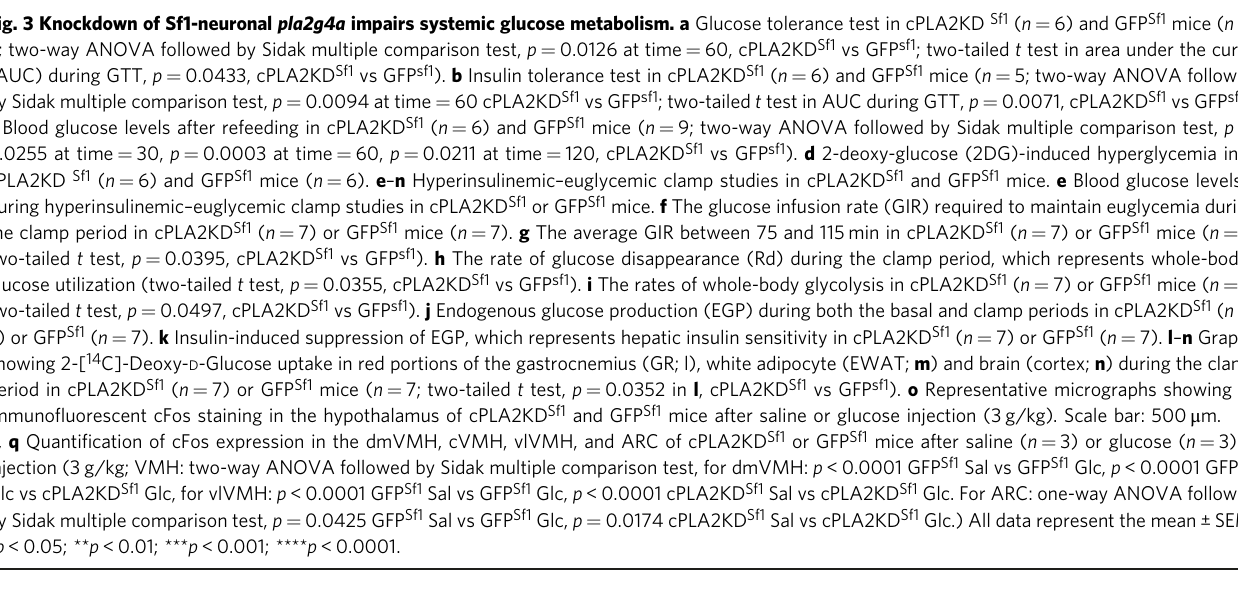
Fig. 3 Knockdown of Sf1-neuronal pla2g4a impairs systemic glucose metabolism. a Glucose tolerance test in cPLA2KD Sf1 ( n = 6) and GFP Sf1 mice ( n = 6; two-way ANOVA followed by Sidak multiple comparison test, p = 0.0126 at time = 60, cPLA2KD Sf1 vs GFP sf1 ; two-tailed t test in area under the curve (AUC) during GTT, p = 0.0433, cPLA2KD Sf1 vs GFP sf1 ). b Insulin tolerance test in cPLA2KD Sf1 ( n = 6) and GFP Sf1 mice ( n = 5; two-way ANOVA followed by Sidak multiple comparison test, p = 0.0094 at time = 60 cPLA2KD Sf1 vs GFP sf1 ; two-tailed t test in AUC during GTT, p = 0.0071, cPLA2KD Sf1 vs GFP sf1 ). c Blood glucose levels after refeeding in cPLA2KD Sf1 ( n = 6) and GFP Sf1 mice ( n = 9; two-way ANOVA followed by Sidak multiple comparison test, p = 0.0255 at time = 30, p = 0.0003 at time = 60, p = 0.0211 at time = 120, cPLA2KD Sf1 vs GFP sf1 ). d 2-deoxy-glucose (2DG)-induced hyperglycemia in cPLA2KD Sf1 ( n = 6) and GFP Sf1 mice ( n = 6). e – n Hyperinsulinemic – euglycemic clamp studies in cPLA2KD Sf1 and GFP Sf1 mice. e Blood glucose levels during hyperinsulinemic – euglycemic clamp studies in cPLA2KD Sf1 or GFP Sf1 mice. f The glucose infusion rate (GIR) required to maintain euglycemia during the clamp period in cPLA2KD Sf1 ( n = 7) or GFP Sf1 mice ( n = 7). g The average GIR between 75 and 115 min in cPLA2KD Sf1 ( n = 7) or GFP Sf1 mice ( n = 7; two-tailed t test, p = 0.0395, cPLA2KD Sf1 vs GFP sf1 ). h The rate of glucose disappearance (Rd) during the clamp period, which represents whole-body glucose utilization (two-tailed t test, p = 0.0355, cPLA2KD Sf1 vs GFP sf1 ). i The rates of whole-body glycolysis in cPLA2KD Sf1 ( n = 7) or GFP Sf1 mice ( n = 7; two-tailed t test, p = 0.0497, cPLA2KD Sf1 vs GFP sf1 ). j Endogenous glucose production (EGP) during both the basal and clamp periods in cPLA2KD Sf1 ( n = 7) or GFP Sf1 ( n = 7). k Insulin-induced suppression of EGP, which represents hepatic insulin sensitivity in cPLA2KD Sf1 ( n = 7) or GFP Sf1 ( n = 7). l – n Graphs showing 2-[ 14 C]-Deoxy- D -Glucose uptake in red portions of the gastrocnemius (GR; l), white adipocyte (EWAT; m ) and brain (cortex; n ) during the clamp period in cPLA2KD Sf1 ( n = 7) or GFP Sf1 mice ( n = 7; two-tailed t test, p = 0.0352 in l , cPLA2KD Sf1 vs GFP sf1 ). o Representative micrographs showing immuno fl uorescent cFos staining in the hypothalamus of cPLA2KD Sf1 and GFP Sf1 mice after saline or glucose injection (3 g/kg). Scale bar: 500 μ m. p , q Quanti fi cation of cFos expression in the dmVMH, cVMH, vlVMH, and ARC of cPLA2KD Sf1 or GFP Sf1 mice after saline ( n = 3) or glucose ( n = 3) injection (3 g/kg; VMH: two-way ANOVA followed by Sidak multiple comparison test, for dmVMH: p < 0.0001 GFP Sf1 Sal vs GFP Sf1 Glc, p < 0.0001 GFP Sf1 Glc vs cPLA2KD Sf1 Glc, for vlVMH: p < 0.0001 GFP Sf1 Sal vs GFP Sf1 Glc, p < 0.0001 cPLA2KD Sf1 Sal vs cPLA2KD Sf1 Glc. For ARC: one-way ANOVA followed by Sidak multiple comparison test, p = 0.0425 GFP Sf1 Sal vs GFP Sf1 Glc, p = 0.0174 cPLA2KD Sf1 Sal vs cPLA2KD Sf1 Glc.) All data represent the mean ± SEM; * p < 0.05; ** p < 0.01; *** p < 0.001; **** p